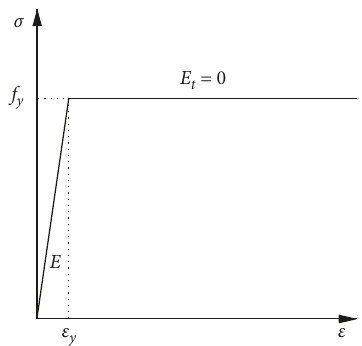
Figure 2: Ideal elastoplastic constitutive